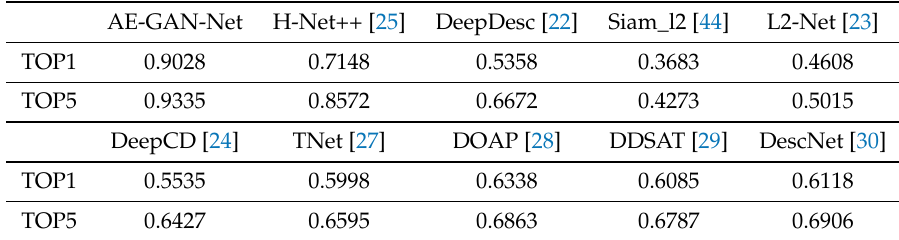
Table 1. The TOP1 and TOP5 retrieval accuracy of proposed AE-GAN-Net and comparative networks on the cross-domain image patch retrieval